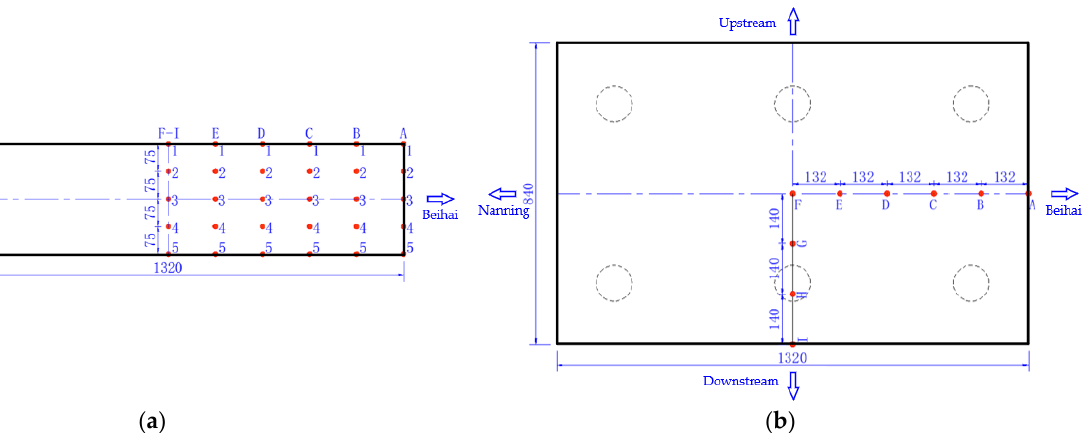
Figure 3. Arrangement of temperature monitoring points for mass concrete in cushion cap: ( a ) elevation; ( b ) plan (unit: cm).